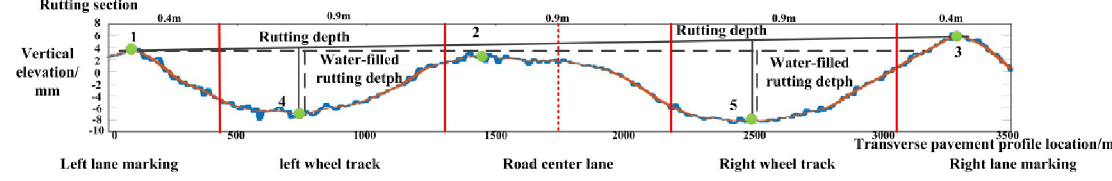
Fig 5. Schematic diagram for the calculation of rut parameters and rut